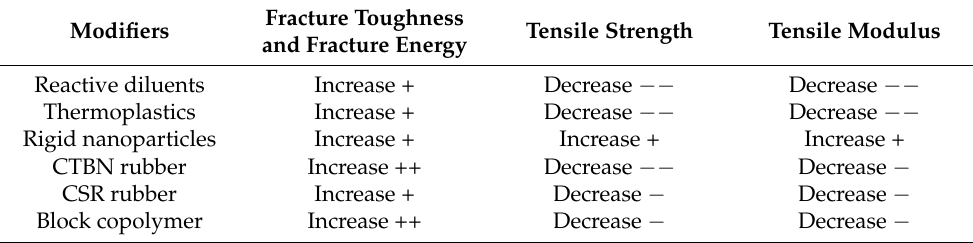
Table 1. Influence of different modifiers on fracture-mechanical properties of epoxy-based mi- cro/nanocomposites. (where “+” corresponds to a small increase and “ −− “ corresponds to a large reduction).